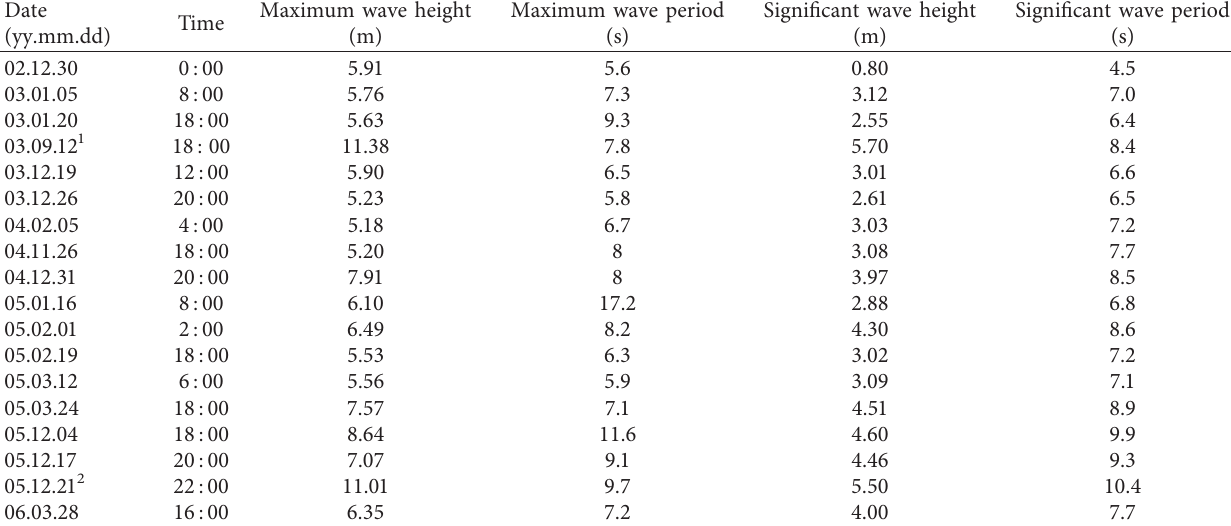
Table 1: Real monitored data measured by a wave gauge installed in front of the west breakwater.